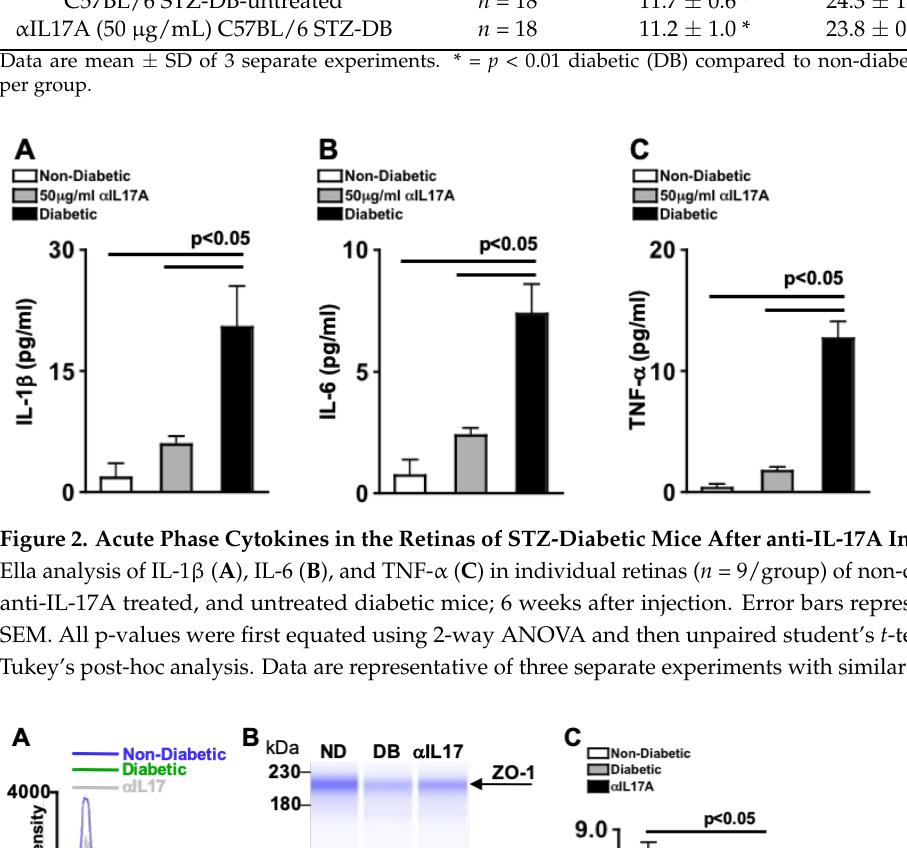
Table 2. Clinical data of STZ-diabetic mice receiving intravitreal injection of anti-IL-17A. Group Number of Mice